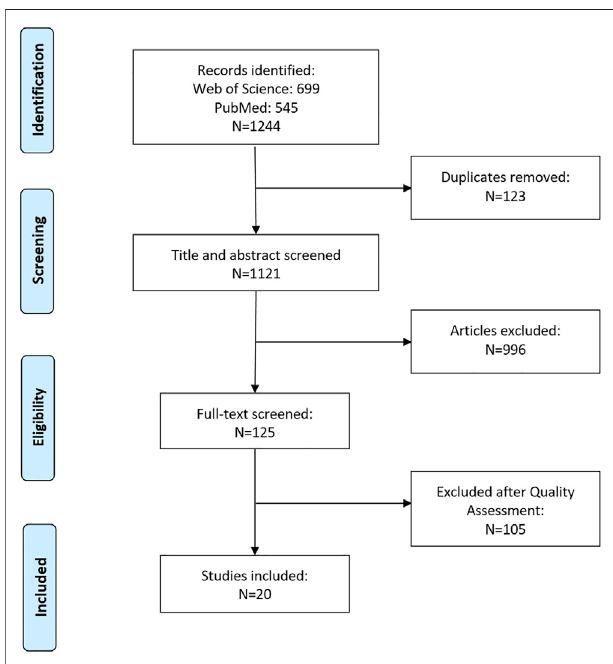
FIGURE 1 | Flow diagram of search